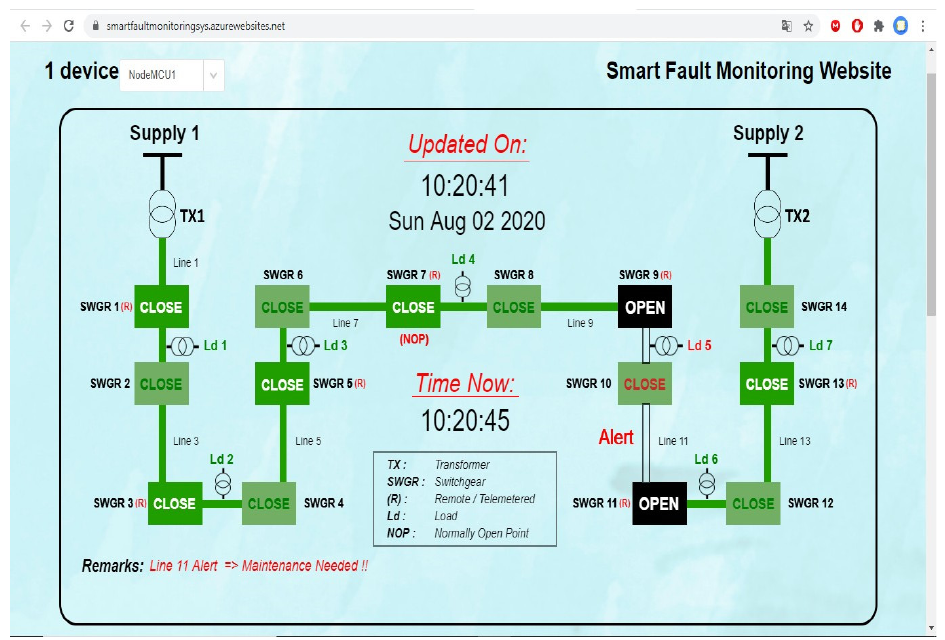
Figure 18. Monitoring website after restoration.